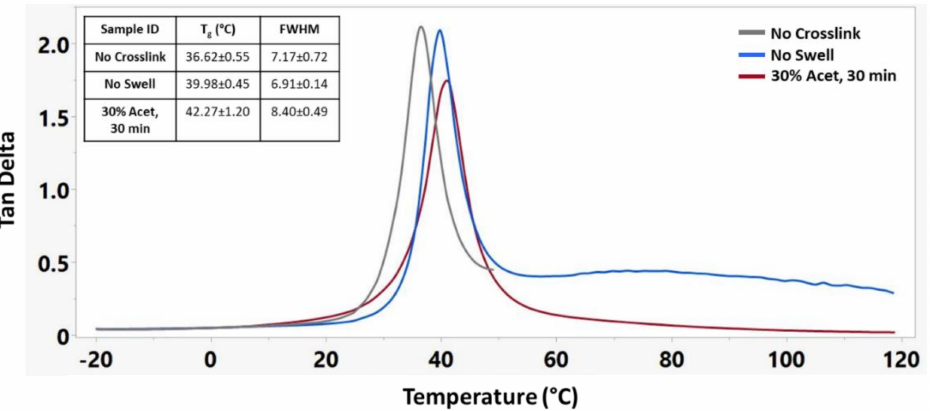
Figure 5. Representative tan delta curves of different crosslinking treatments along with correspond- ing T g ’s and full width half maximum (FWHM) measurements. n = 3 for each sample group.